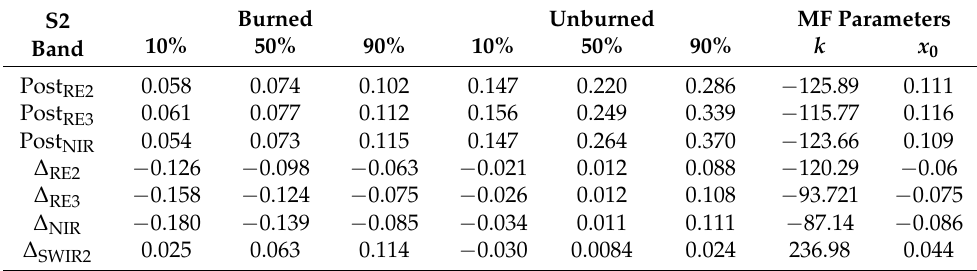
Table 4. Percentiles of the frequency distribution functions extracted from the training pixels of the study area and used for defining